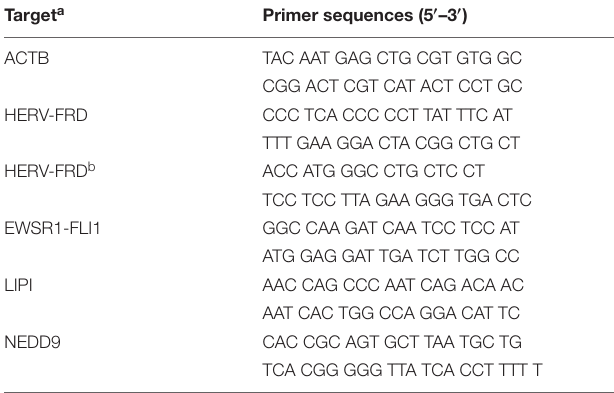
TABLE 1 | Primer combinations used in this